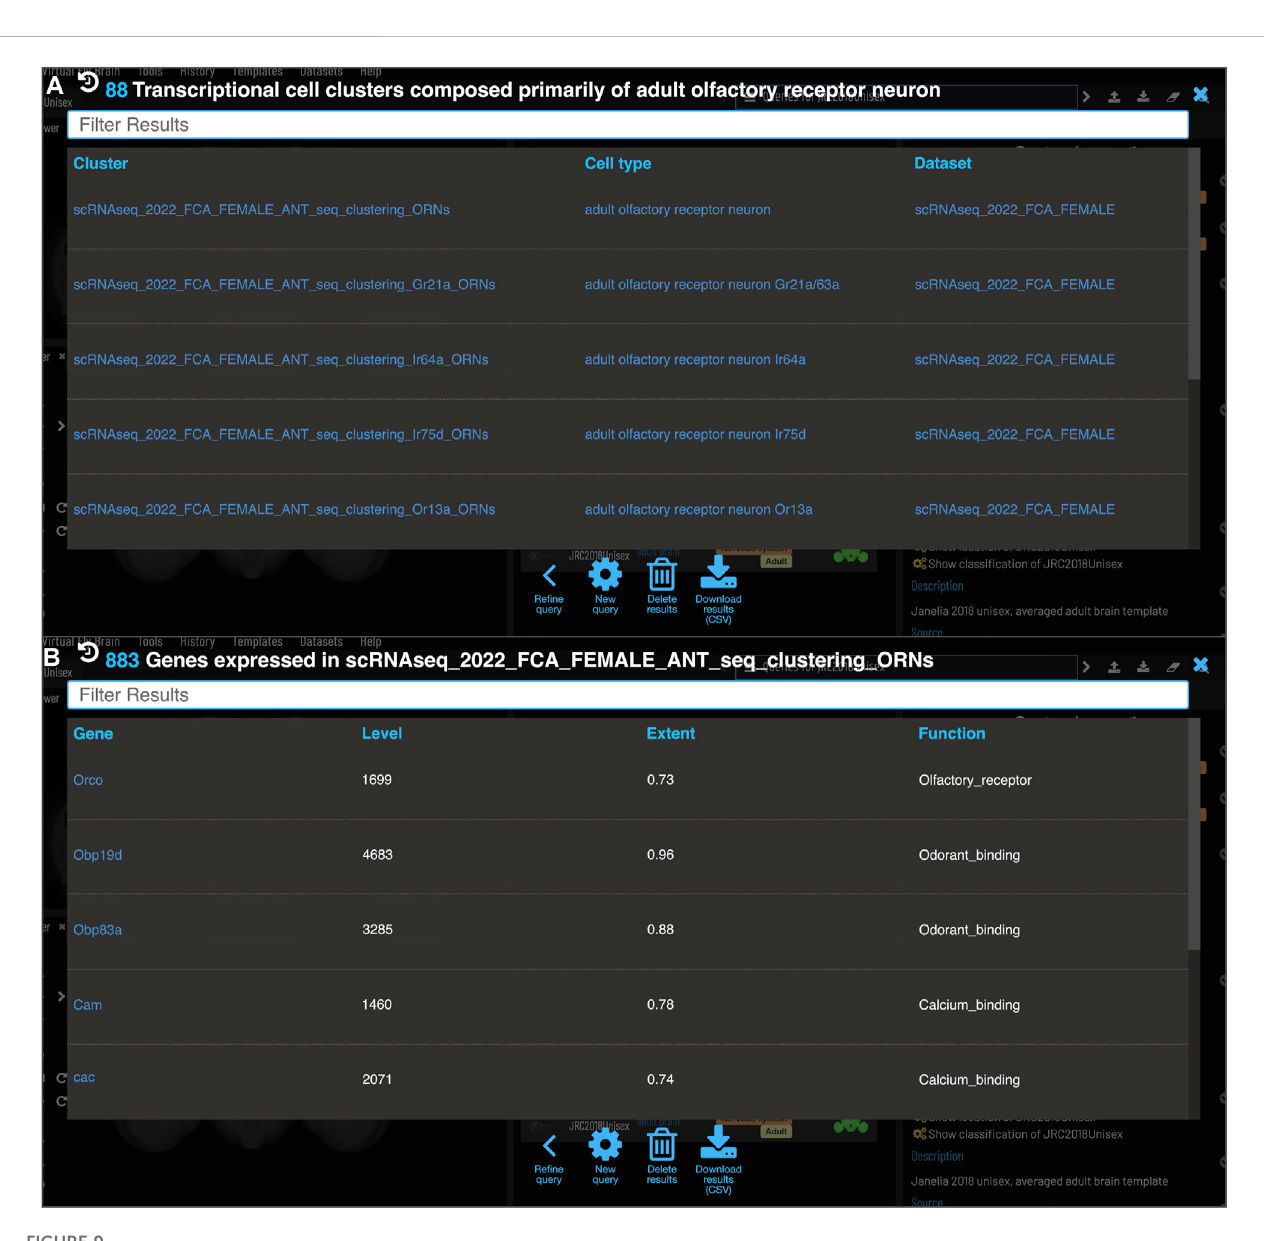
FIGURE 9 Single Cell RNAseq (not yet live) (A) Each transcriptional cluster is linked to a cell type in the Drosophila Anatomy Ontology (curation done by Single Cell Expression Atlas and FlyBase) facilitating searches based on cell type (typically more general types than we have for connectomics data). (B) Each gene expressedinmore than half of the cells ina cluster will be viewable in VFB with its expression level and extent(proportion ofcells in cluster that transcript was detected in) and semantic tags representing the gene ’ s function (based on GO and Gene Group annotations from